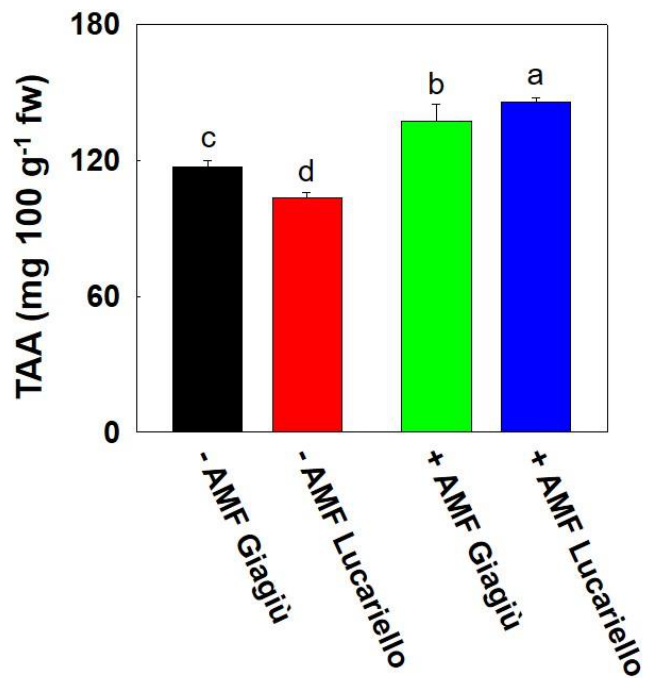
Figure 2. Effects of arbuscular mycorrhizal fungi (AMF) on total ascorbic acid (TAA) of yellow-pigmented type (‘Giagiù’) and red-pigmented type (‘Lucariello’) landraces of ‘Pomodorino del Piennolo del Vesuvio’ (PPV) cultivated in Campania region under rainfed conditions. Values are the means of three replicates ± SD. Different letters indicate significant differences according to Duncan’s test ( p = 0.05).